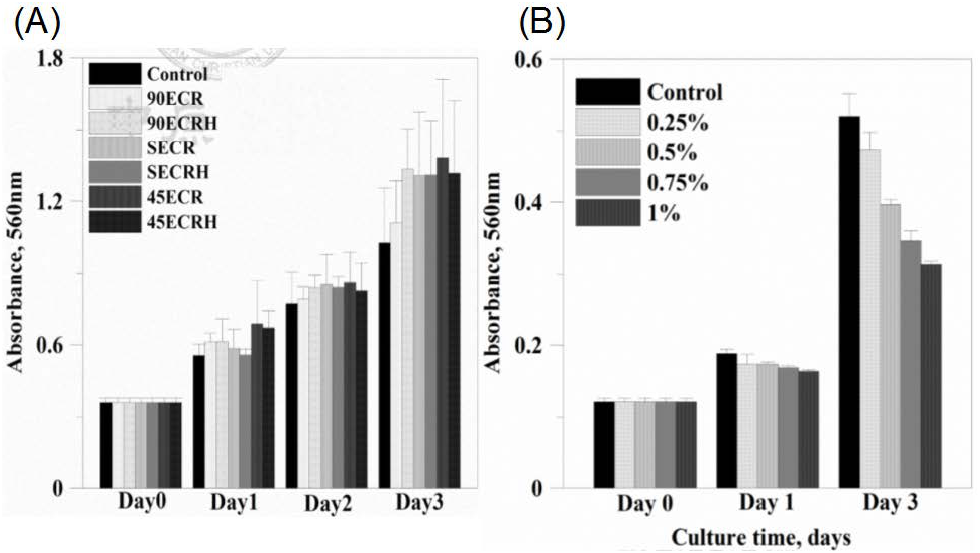
Figure 7. Cytotoxity of ( A ) scaffolds and ( B ) GMHA by MTT assay. Error bars represent means with standard deviation.